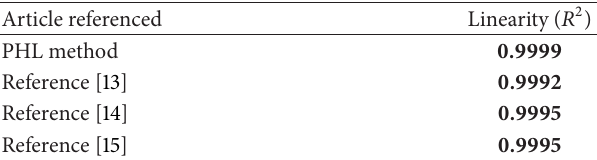
Table 2: Comparison of linearity for the Washington State Depart- ment of Health (PHL) method and three LC/MS/MS methods